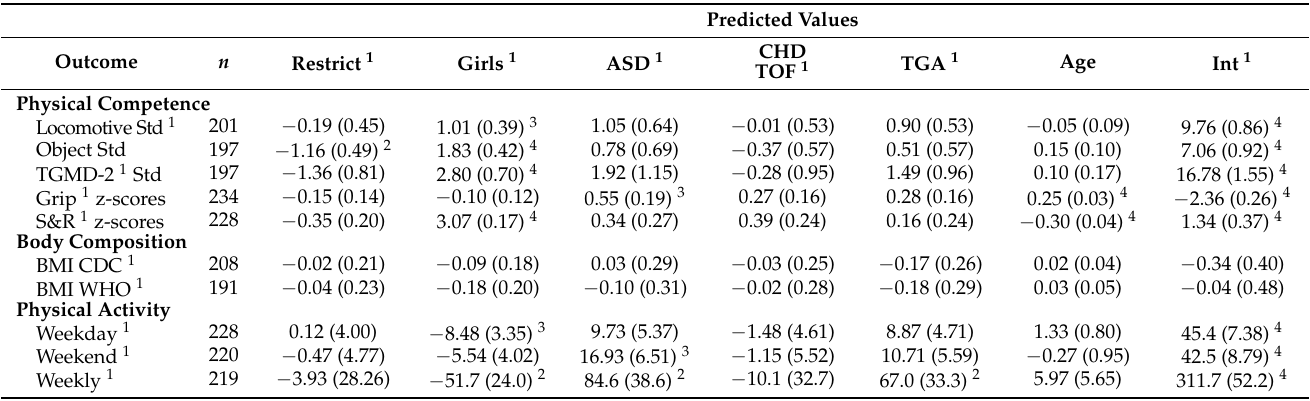
Table 5. Association between health-related fitness and any type of parent-reported restriction among children with CHD, adjusting for sex, age, and type of